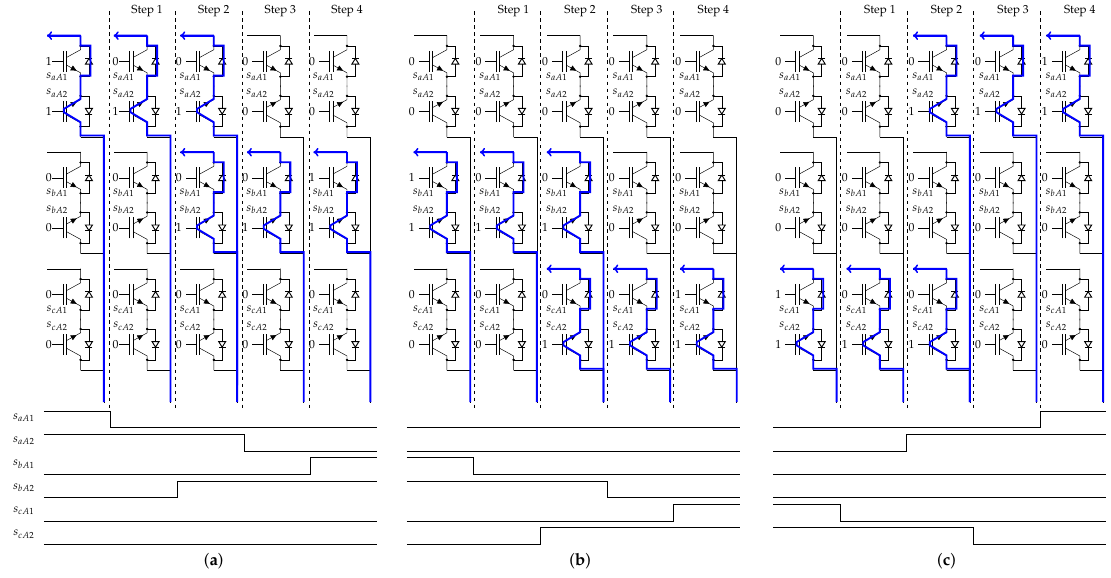
Figure 7. Four-step commutation logical signals, incoming current case, for the transitions ( a ) s aA to s bA , ( b ) s bA to s cA , and ( c ) s cA to s aA